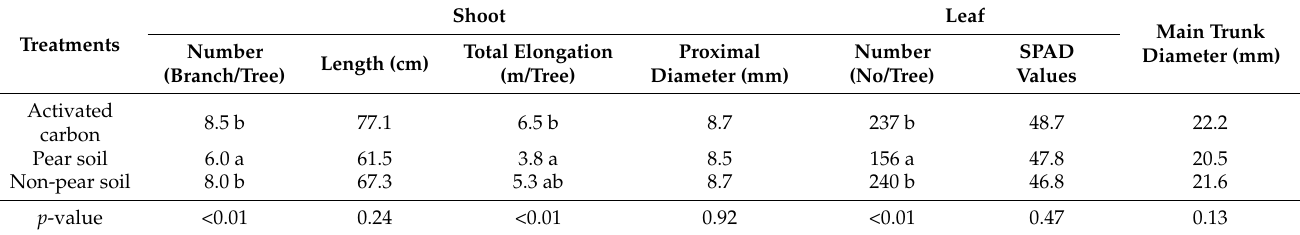
Table 4. The growth of trees in soil mixed with activated carbon.